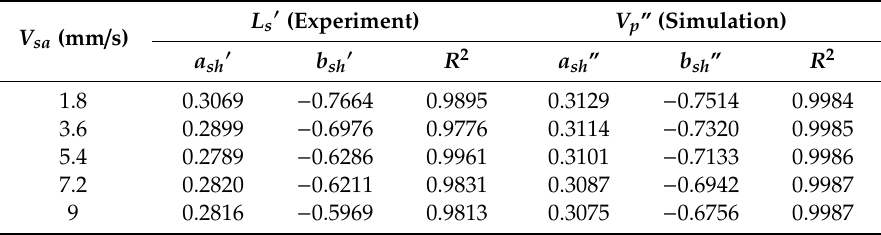
Table 9. The fitted coefficients of L s ’ and V p ″ versus sample flow velocity V sa at five different sheath flow velocities V sh .